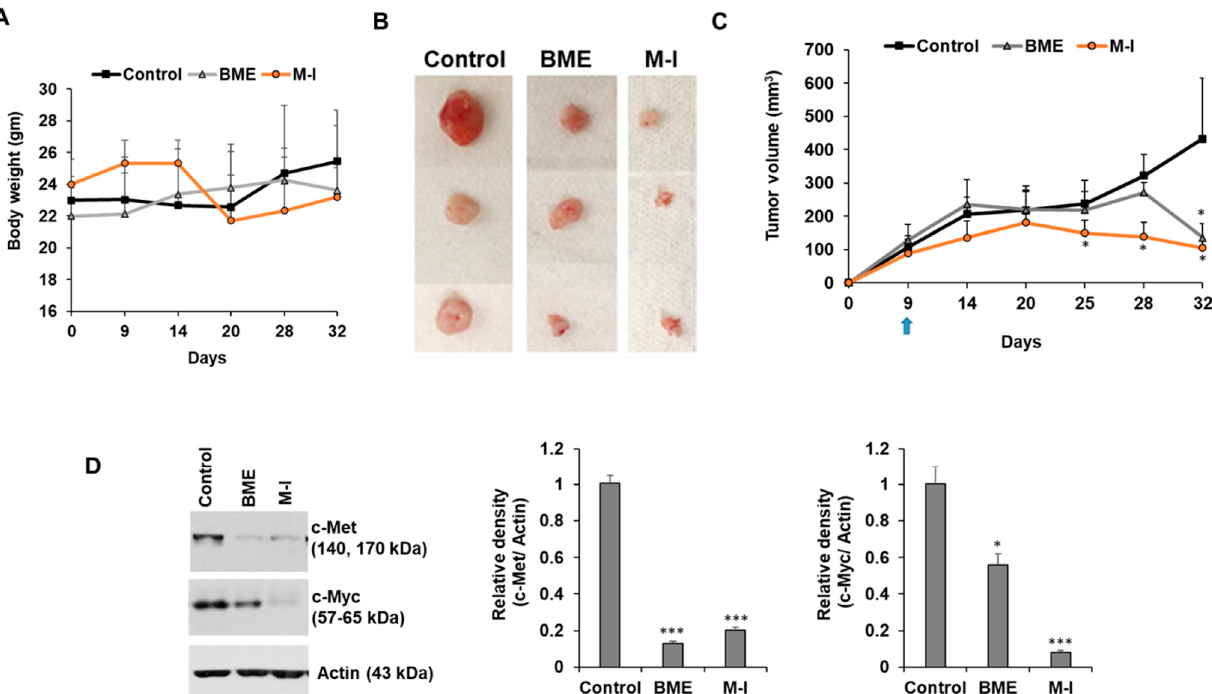
Figure 6. Therapeutic effect of momordicine-I in JHU029 xenograft model. JHU029 cells (1.5 × 10 6 ) cells were injected subcutaneously into the flank of nude mice. After the formation of a palpable tumor, mice were randomly divided into three groups ( n = 5): Control (without any treatment), BME group (30% BME through drinking water) and M-I group (30 mg/kg IP, once in a day and every day). ( A ) Body weight was measured in control and treated mice. ( B ) Representative images of tumors in control and treatment groups. ( C ) Tumors were measured using a slide caliper and tumor volumes were calculated. Arrow indicates starting point BME/M-I treatment. ( D ) Control or treated tumor lysates were subjected to Western blot analysis for c-Met and c-Myc expression using specific antibodies and representative bands are shown. The blot was reprobed with an antibody to Actin for normalization. Right panel shows quantitation. Small bar indicates standard error (*, p < 0.05; **, p < 0.01; *** p < 0.001). Uncropped western blots figures are shown in Figure S6.